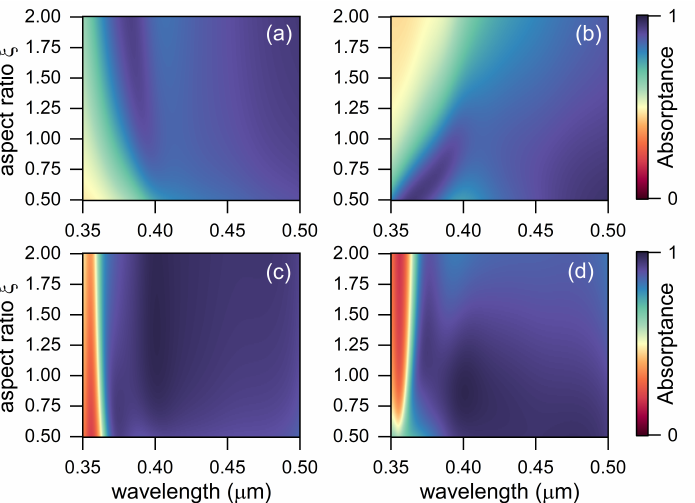
Figure 2. Absorptance in the PSL with spheroidal NPs in a conventional solar cell shown in Figure 1a for the electric field vector ( a ) perpendicular and ( b ) parallel to the optical axis of the NPs in the PSL. Absorptance in the PSL with spheroidal NPs in the TPP-based solar cell shown in Figure 1b for the electric field vector ( c ) perpendicular and ( d ) parallel to the optical axis of the NPs in the PSL.